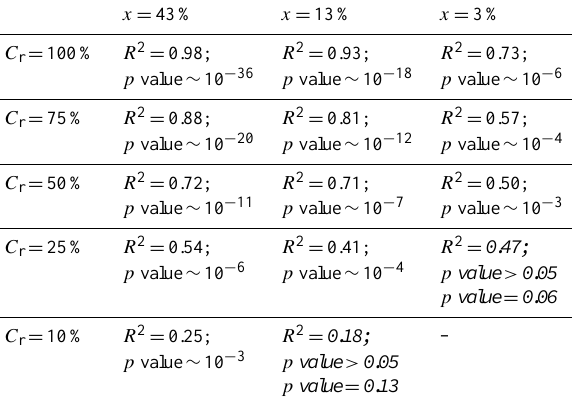
Table 4. R 2 and p values of the linear regression line obtained by the proposed method for three virtual databases. C r corresponds to the correlation rate between rainfall and number of events, and x corresponds to the proportion of days with events. The results shown in italic identify non-significant